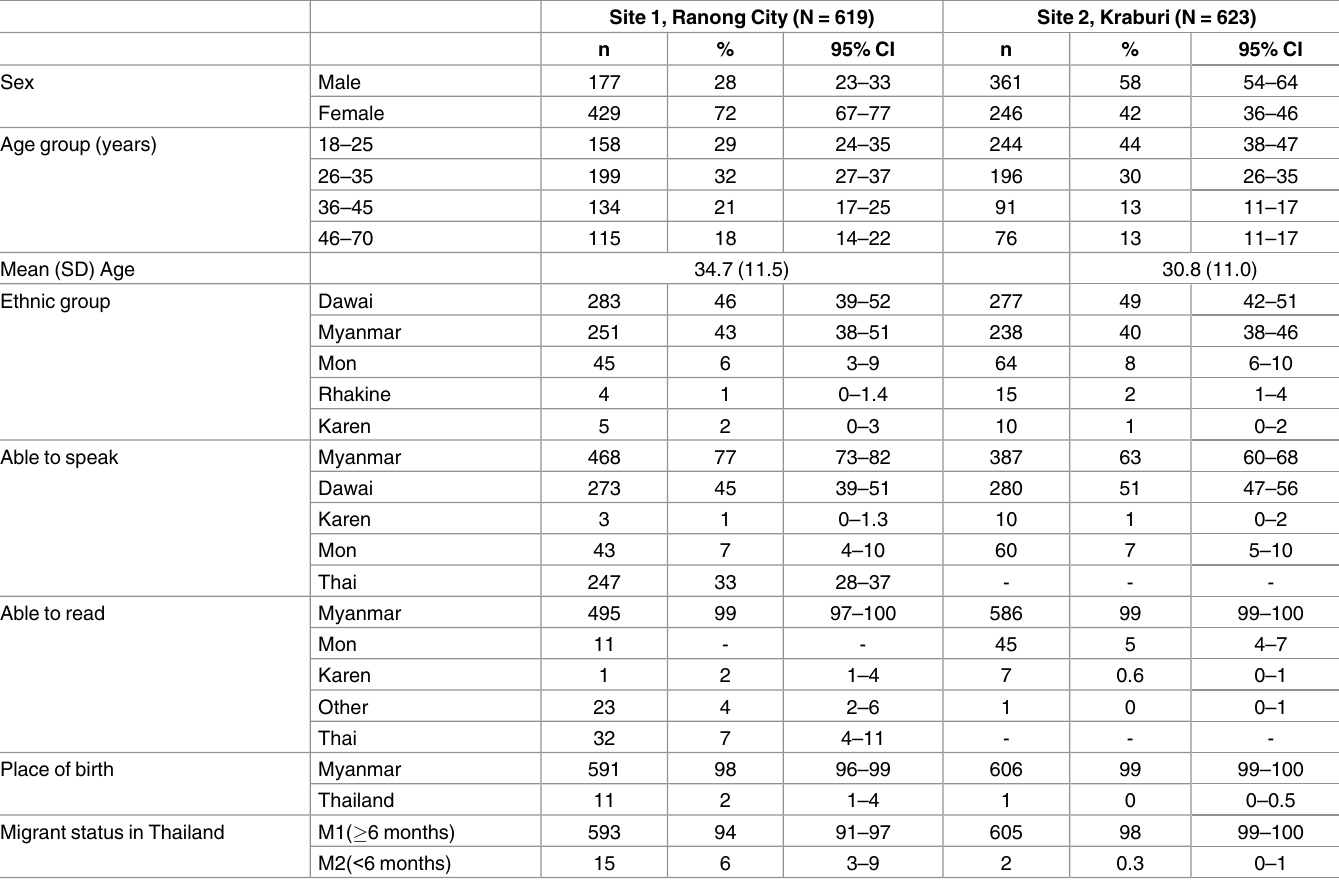
Table 1. RDS-weighted estimates of basic demographic characteristics of respondents by